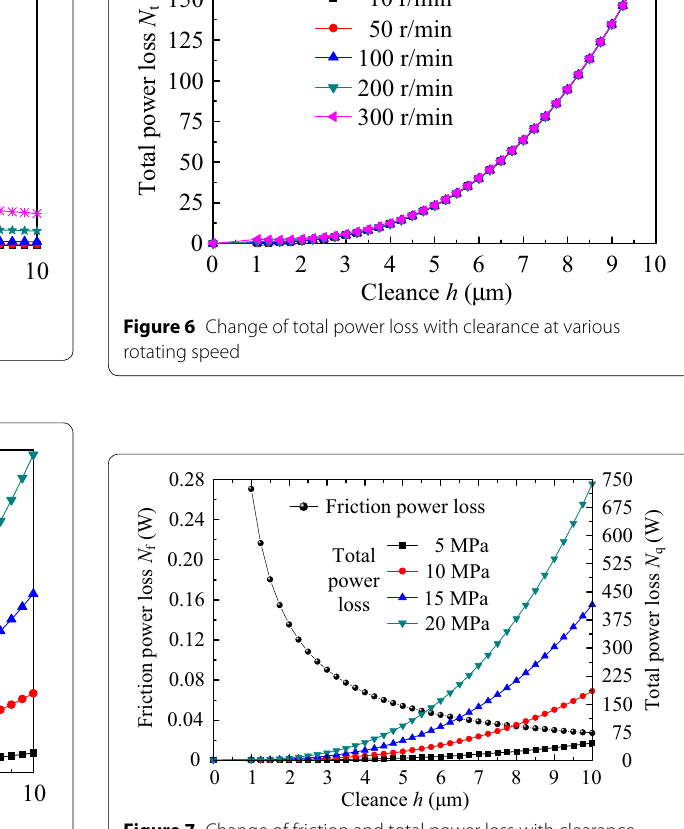
Figure 7 Change of friction and total power loss with